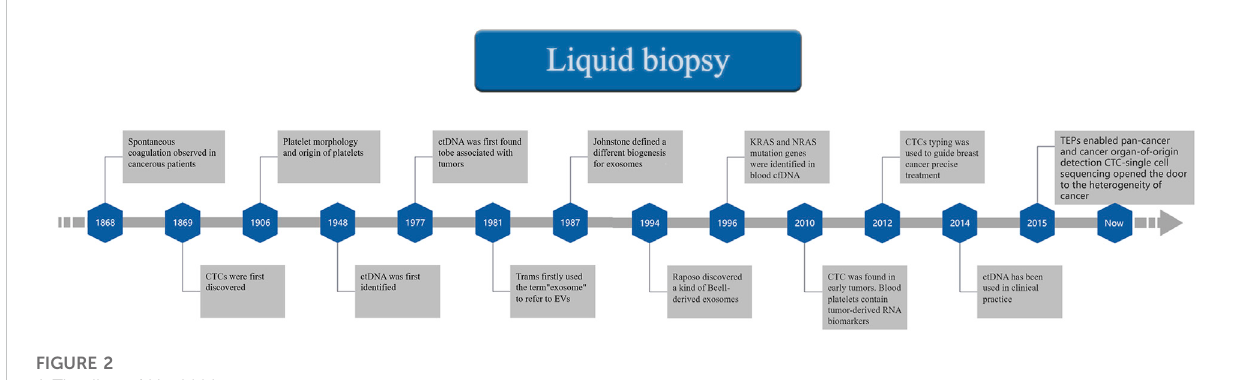
A Timeline of Liquid